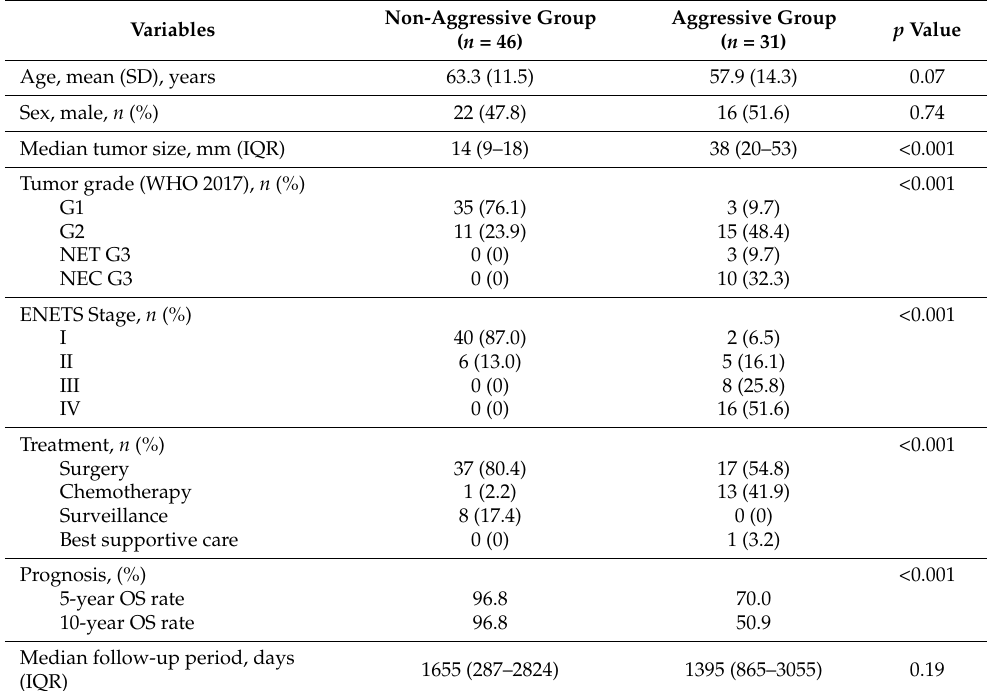
Table 2. Baseline characteristics between the non-aggressive and aggressive